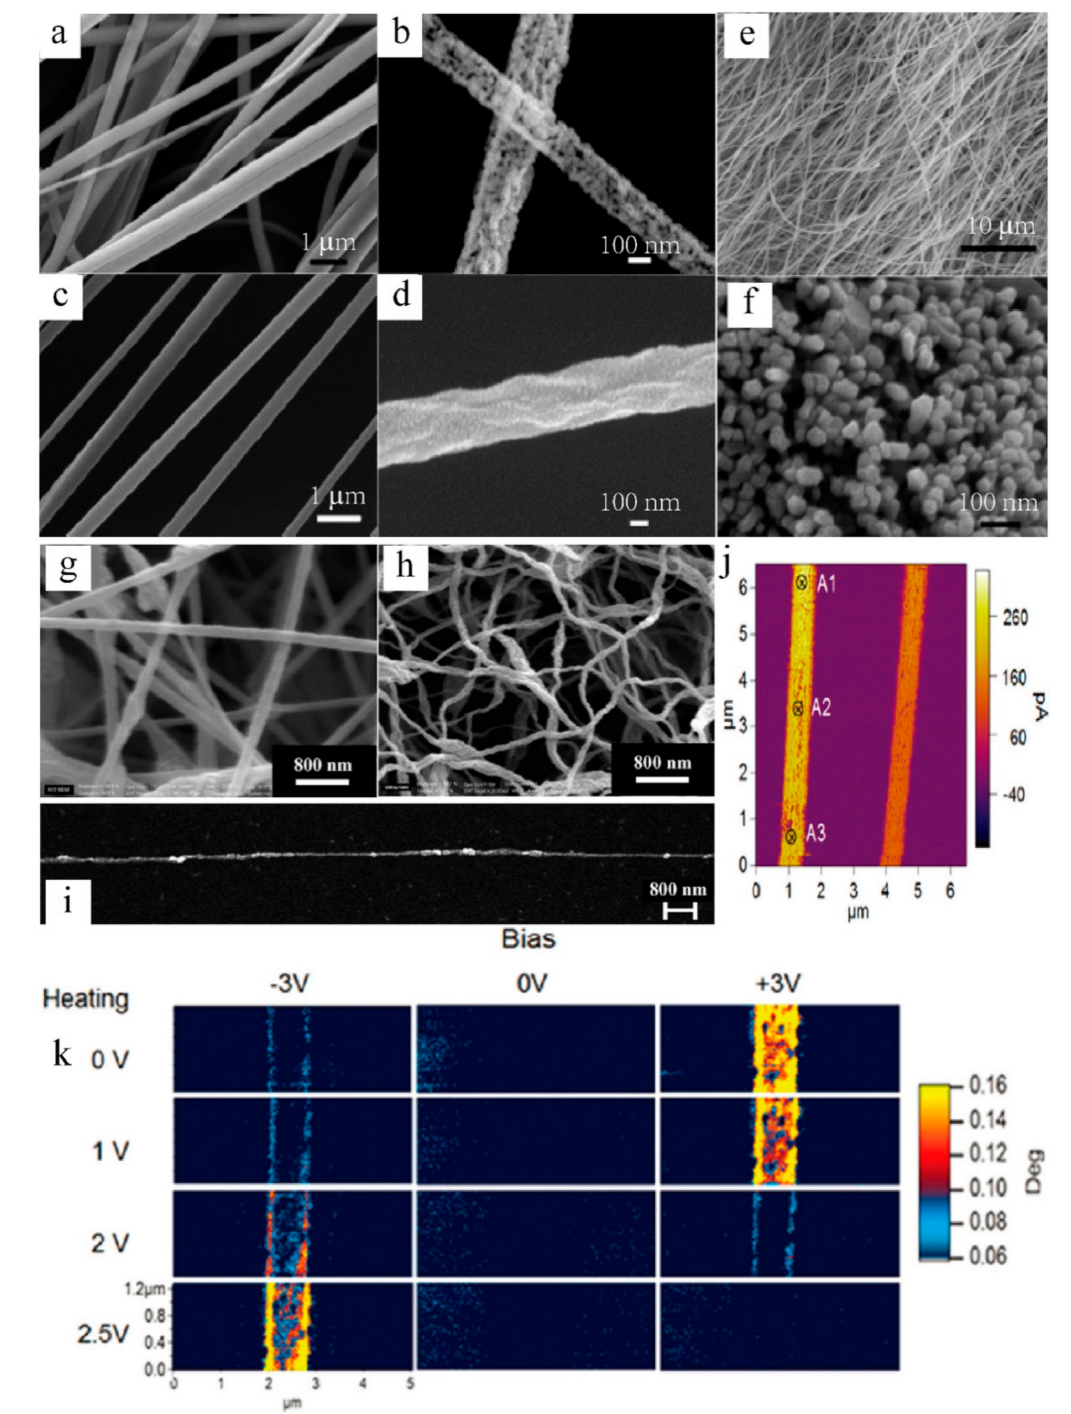
Figure 5. ( a – d ) SEM images of synthesized NaCo 2 O 4 nanofibers using two different solvents before and after annealing. ( d ) Sketch of the molten core drawing process. ( e ) SEM image of as-spun nanofiber mat before annealing. ( f ) SEM images of nanofibrous mat annealed at 750 ◦ C for 10 min. Reproduced with permission [61]. Copyright 2010, American Chemical Society. ( g ) SEM micrographs of sodium acetate/cobalt acetate/PAN composite fibers and ( h ) NaCo 2 O 4 fibers. ( i ) A single-aligned NaCo 2 O 4 fiber coated on Si substrate. Reproduced with permission [57]. Copyright 2006, Elsevier. ( j ) The measurement of I–V curve for nanofiber. ( k ) Electrostatic force microscopy (EFM) contrast variation in NaCo 2 O 4 nanofiber vs. bias voltage with different heating voltages. Reproduced with permission [61]. Copyright 2010, American Chemical